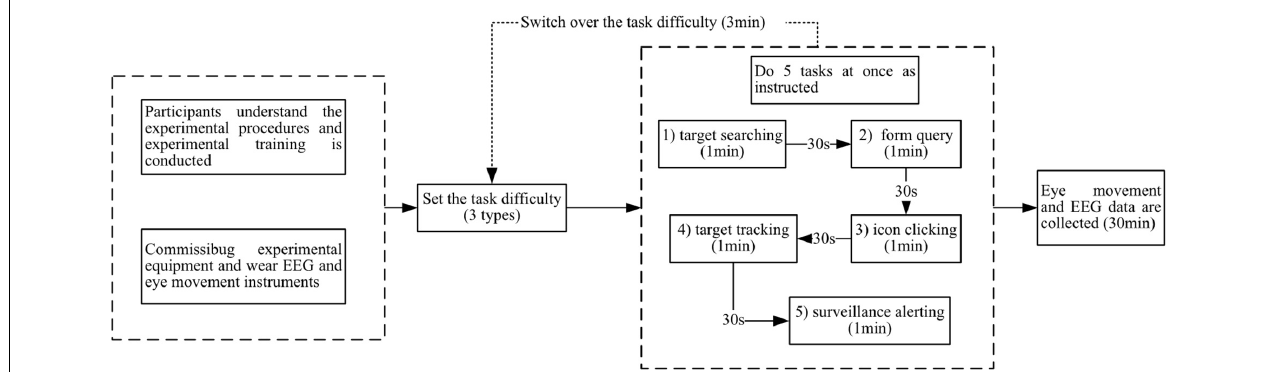
FIGURE 7 | Experimental process.